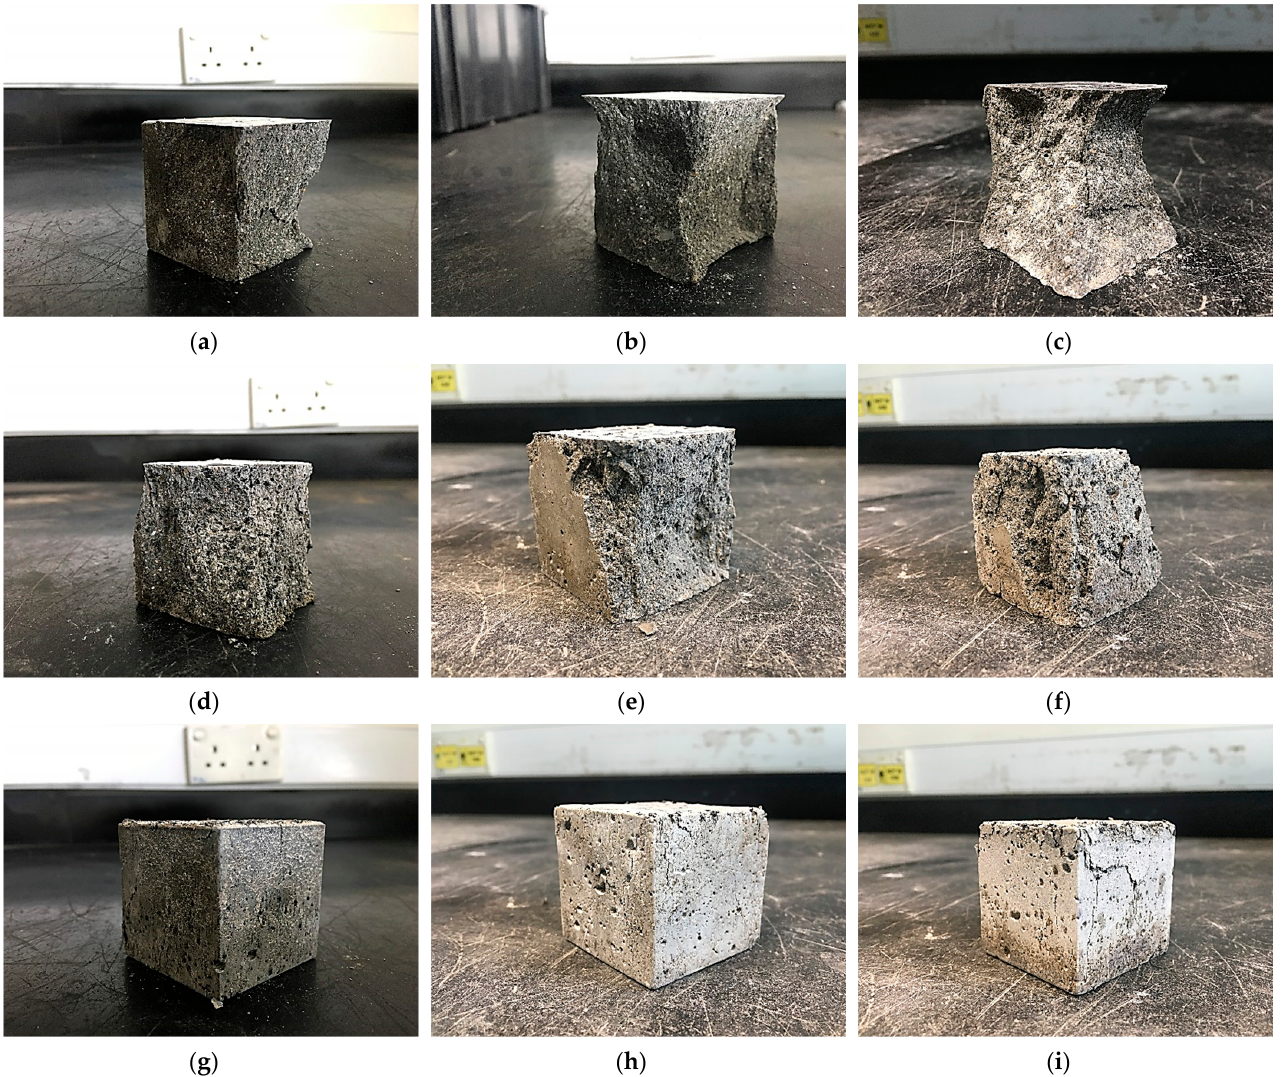
Figure 3. Crushed cube samples of NS-CRM mixes at 28 days: ( a ) CR0-NS0; ( b ) CR0-NS2.5; ( c ) CR0-NS5; ( d ) CR7.5-NS0; ( e ) CR7.5-NS2.5; ( f ) CR7.5-NS5; ( g ) CR15-NS0; ( h ) CR15-NS2.5; ( i ) CR15-NS5.